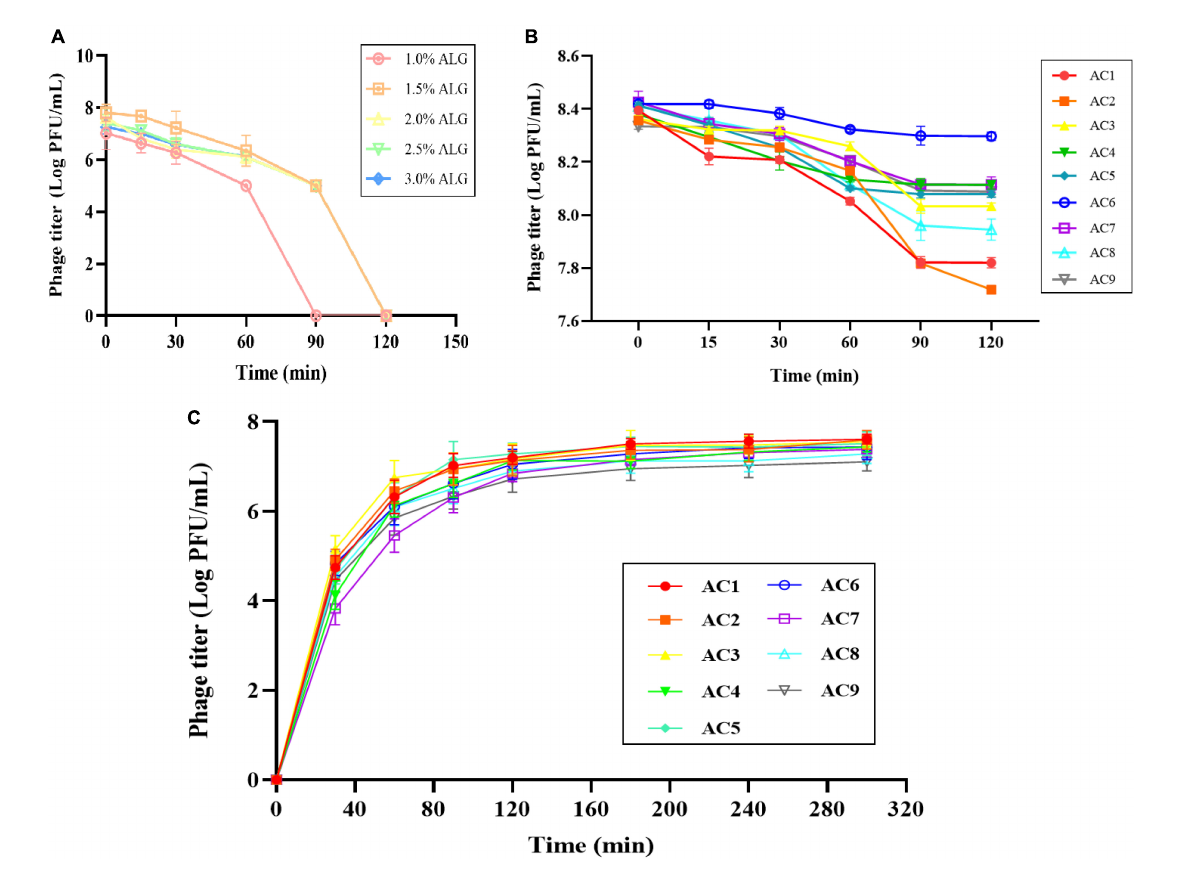
FIGURE5 Stability and release characteristics of phage microcapsules in vitro digestion. The stability in SGF (A) Pure ALG microcapsules. (B) AC microcapsules. (C) The release behavior of phage loaded within AC microcapsules. AC1–AC9 represents polysaccharide mixtures in different proportions. (AC1) 1%ALG and 0.15%CG, (AC2) 1.5%ALG and 0.15%CG, (AC3) 2%ALG and 0.15%CG, (AC4) 1%ALG and 0.3%CG, (AC5) 1.5%ALG and 0.3%CG, (AC6) 2%ALG and 0.3%CG, (AC7) 1%ALG and 0.45%CG, (AC8) 1.5%ALG and 0.45%CG, (AC9) 2%ALG and